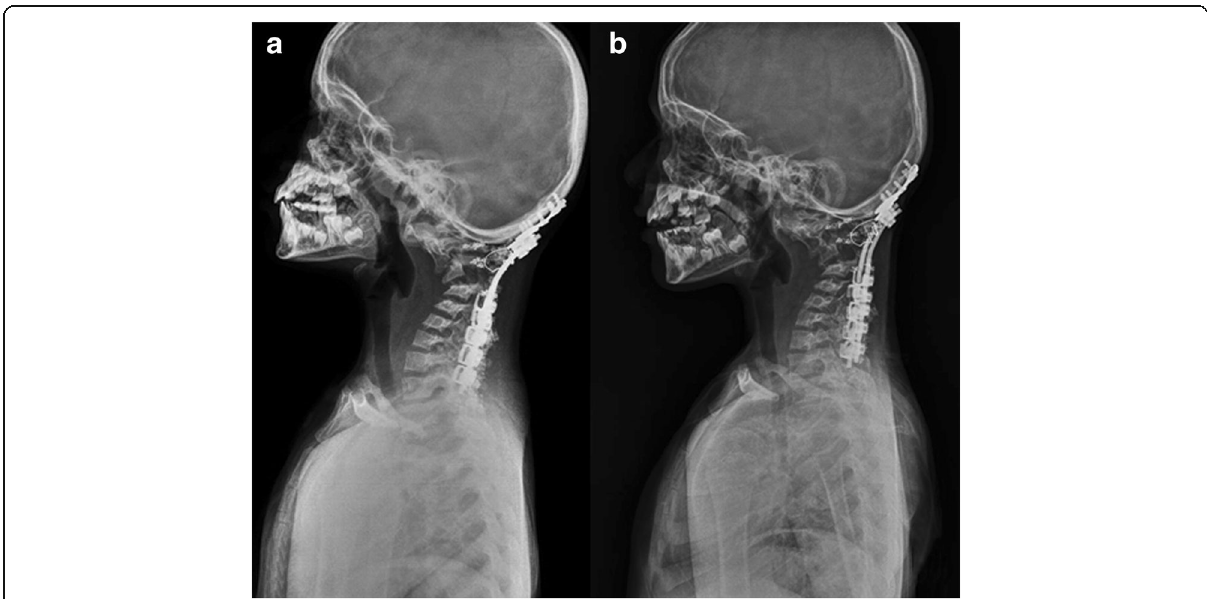
Fig. 5 a Long segment rigid fixation between occiput and T1 vertebral body with sublaminar wires and laminar hooks. b Lateral cervical X-ray